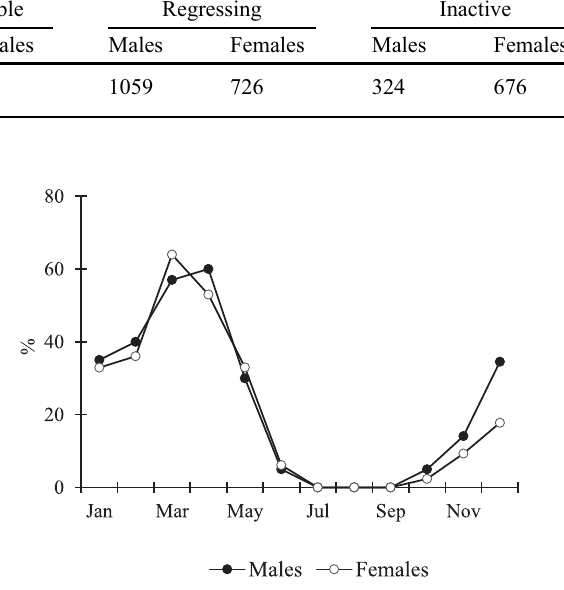
Fig. 5. Mean monthly frequency of spawning stage (stage 3) for male and female T. picturatus from north-east Atlantic waters (Portuguese